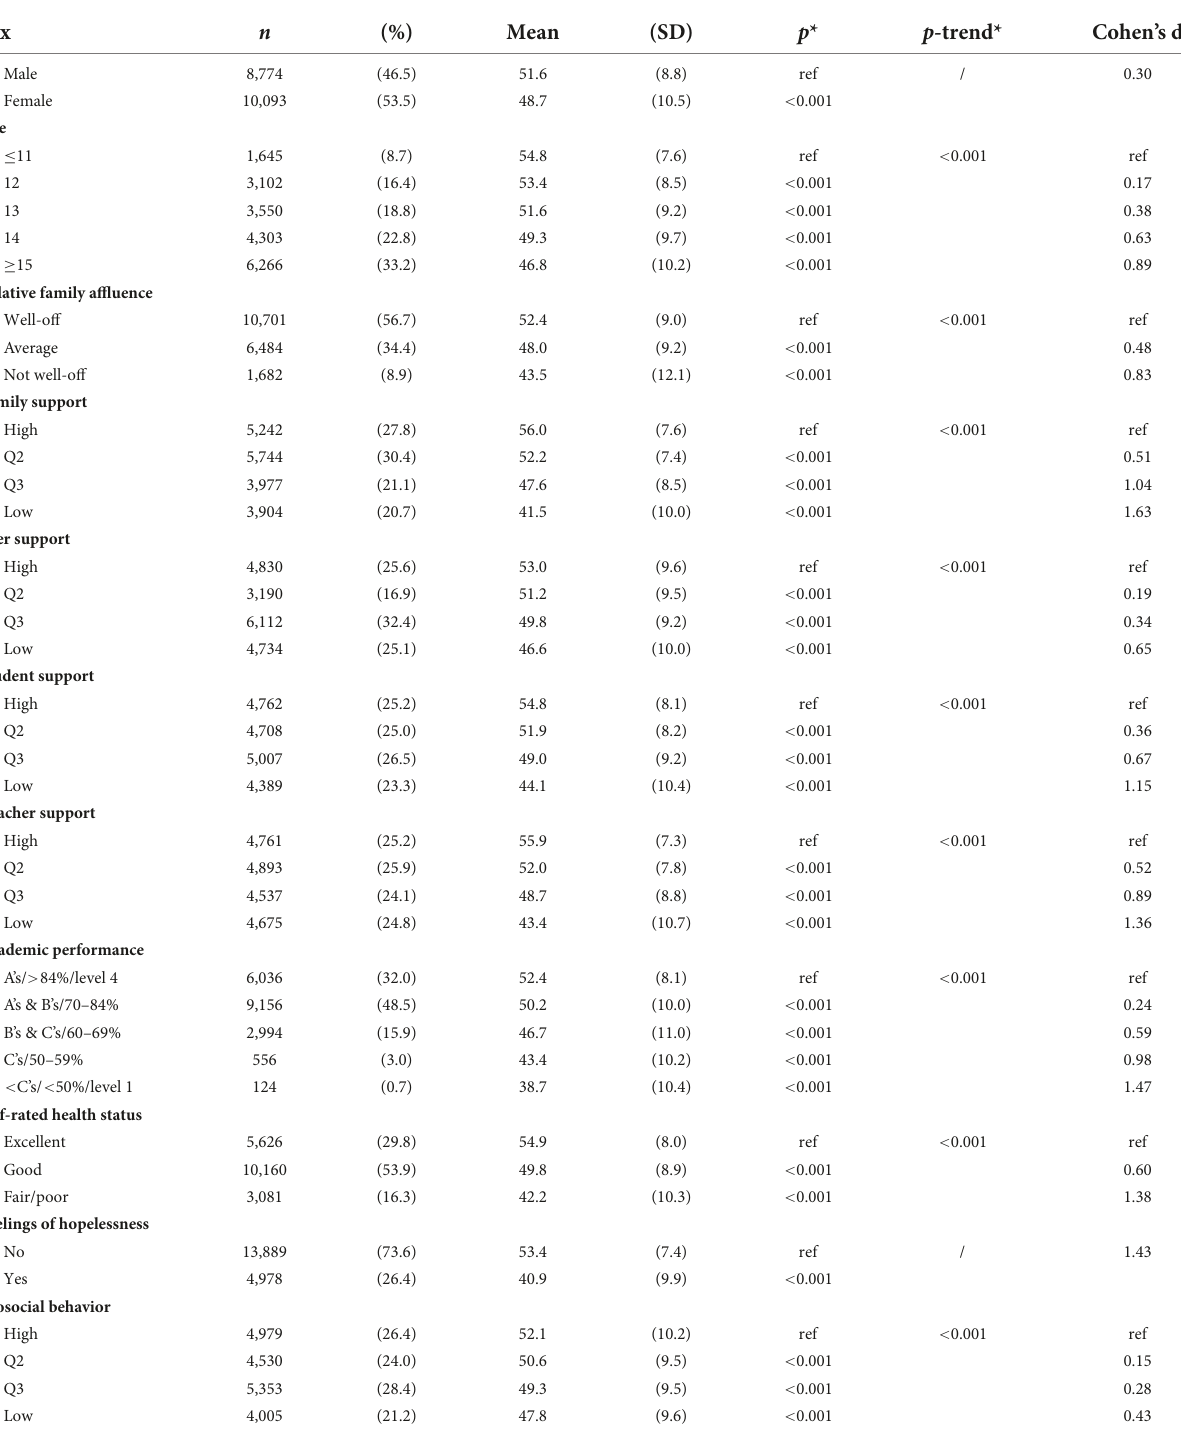
TABLE 1 Description of the 2014 HBSC sample by average mental health